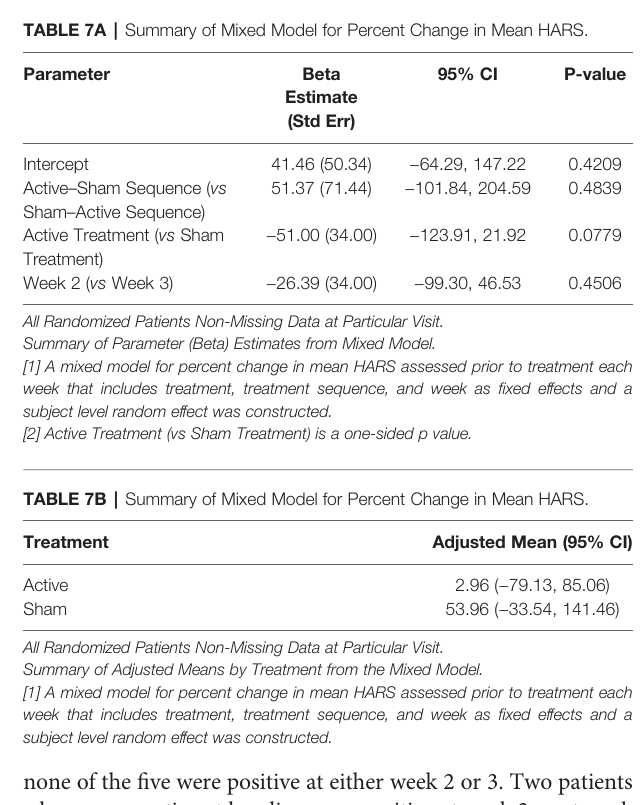
TABLE 6A | Summary of Mixed Model for Percent Change in Mean HDRS.